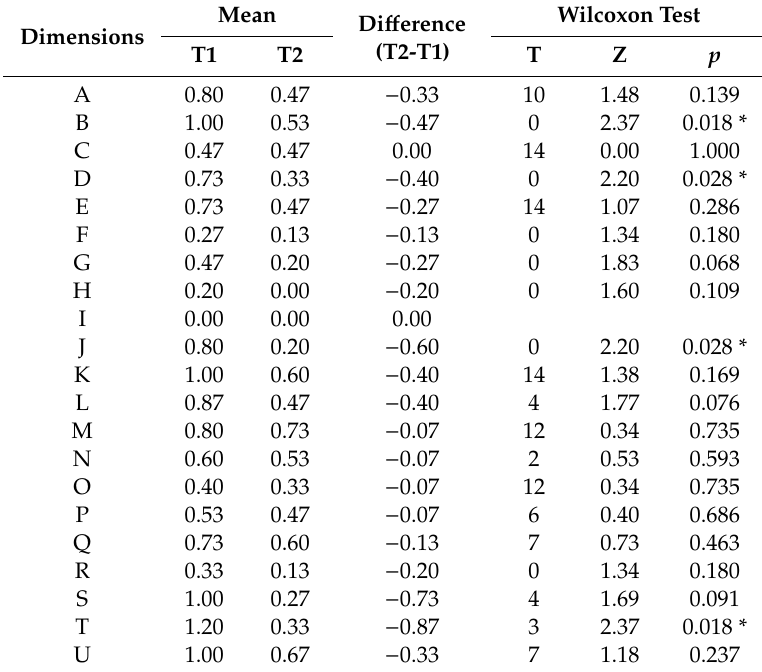
Table 5. Qualitative di ff erences in particular dimensions from Beck’s Depression Scale (BDI) for the massage group